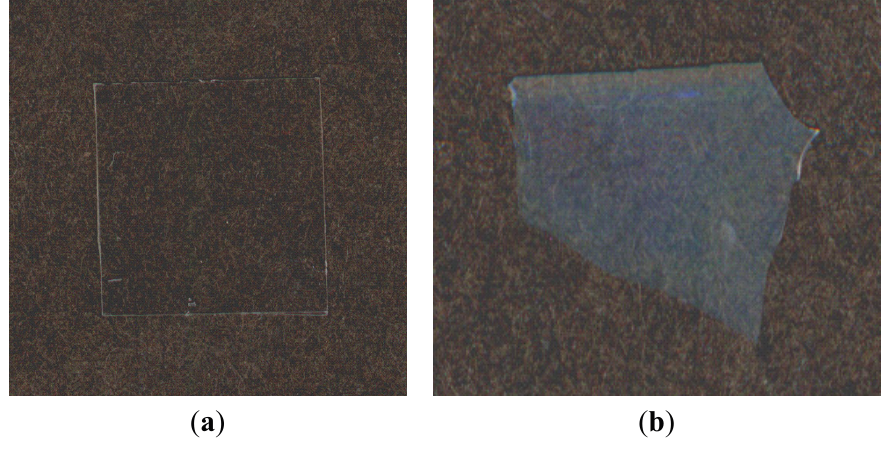
Figure 23. Photographs of an H-q sample ( a ) before and ( b ) after a 20-day enzymatic hydrolysis. Reproduced with permission from ref. [59]. Copyright 2004 American Chemical